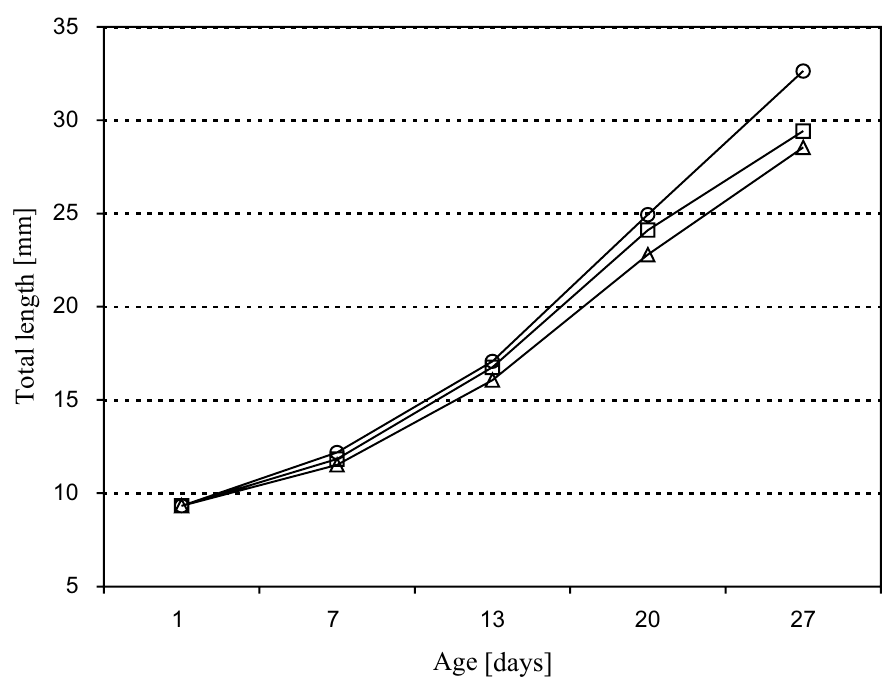
Fig.1. Mean length[mm]of pike larvae during the growing-out operation in tanks with different habitats;tankswith black garden poly- ethylene foil (F) denoted with ! ; tanks with vascular plants (R) denoted with " ; tanks with plastic netting (S) denoted with !